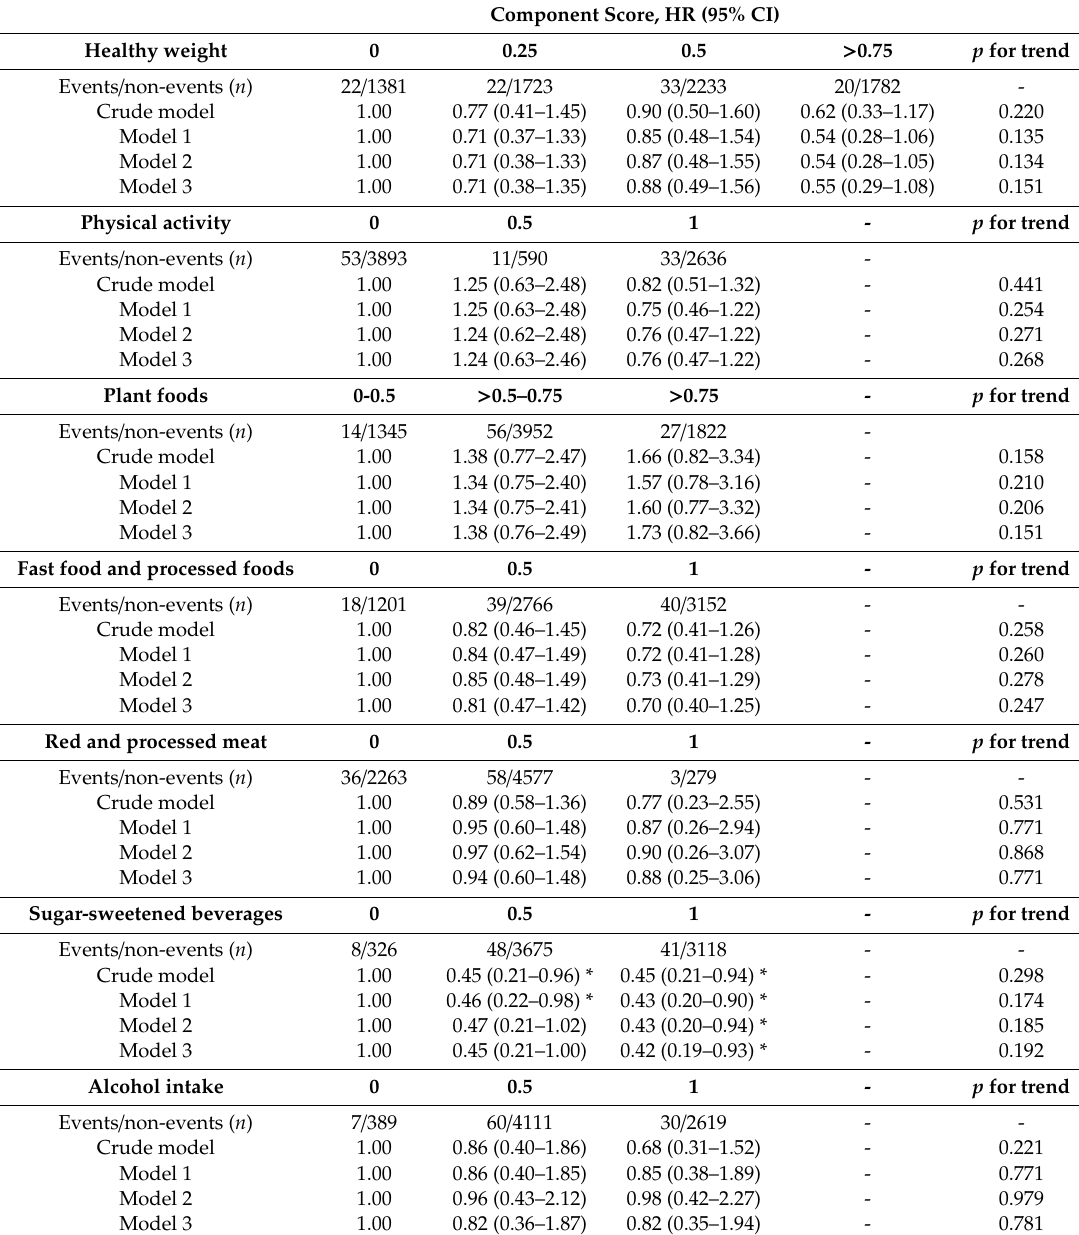
Table 3. Mutually adjusted HRs and 95% CIs for colorectal cancer risk associated with categories of individual components of the 2018 WCRF / AICR score at baseline in the PREDIMED study ( n =